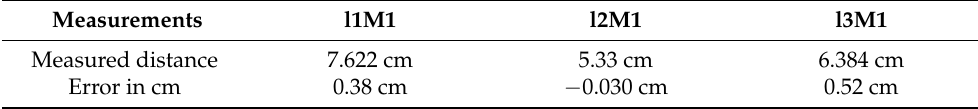
Table 3. Error compared with SolidWorks ® measurements.